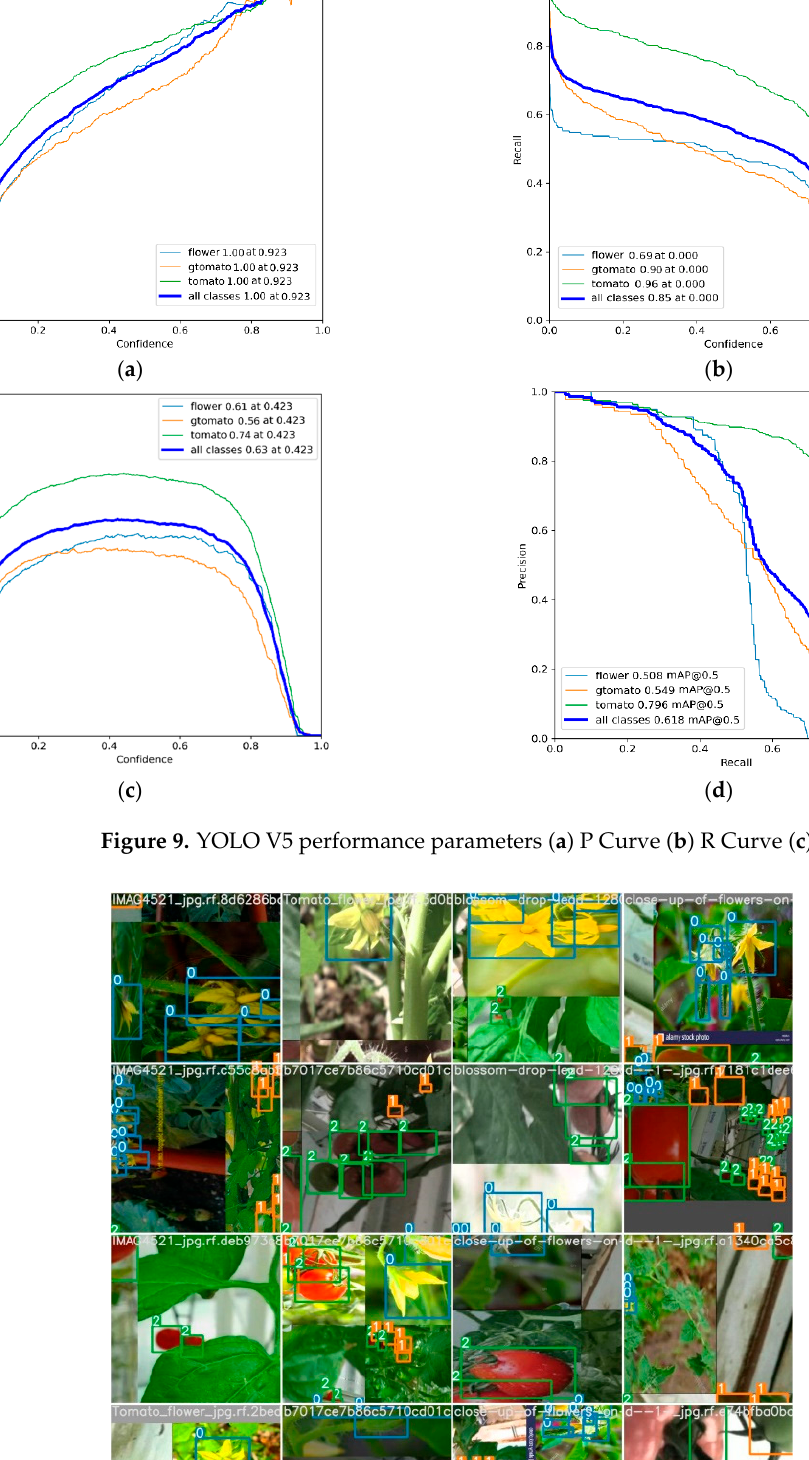
Figure 11. Obtained test results batch with accuracy for Tomato detection model. Here, green and orange colored bounding boxes represent red tomato and green tomato classes, respectively After analyzing the whole model, the best training weights (coefficients) are saved and converted to the Tensor Flow model. Later, the Deep-Sort algorithm was applied to the trained model to follow the detected tomatoes with respect to their locations. To count the tomatoes, two lines were placed at the bottom of the image frames. The algorithms count anytime a tomato passes these two yellow lines, as indicated in Figure 12.